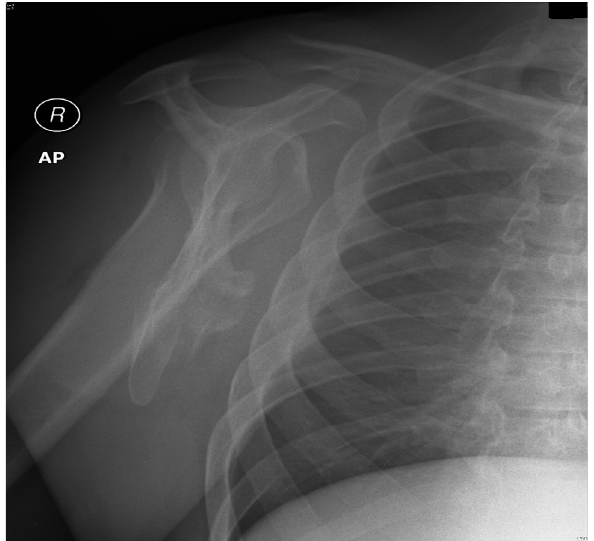
Figure 5. Lateral view of plain radiograph of right scapula demonstrating a broad based pedunculated